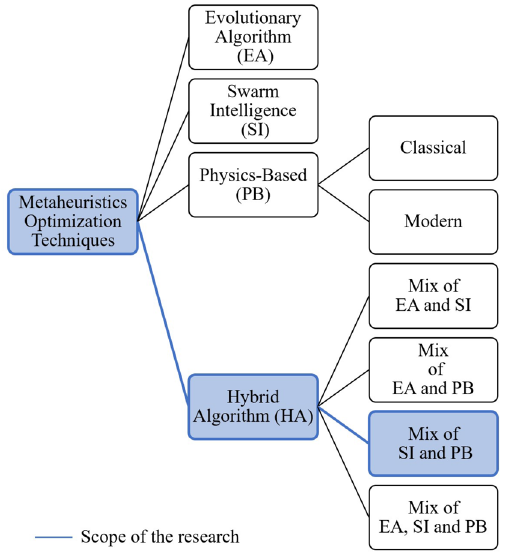
Figure 1. Classification of metaheuristics optimization